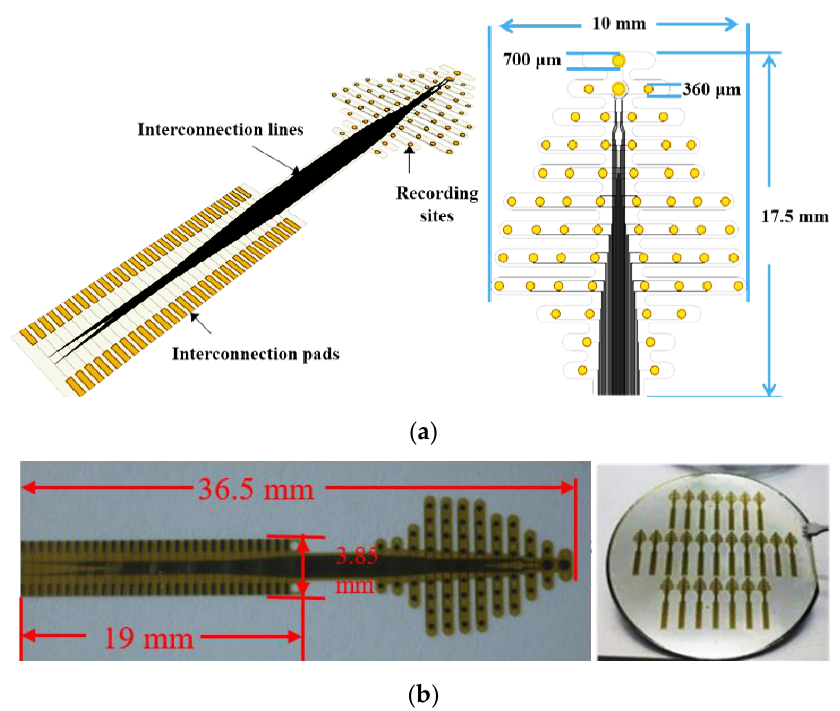
Figure 3. Images of the designed and fabricated MEAs: ( a ) The designed structure of a single MEA and ( b ) a single fabricated MEA with the fully processed 6-inch silicon supporting wafer and